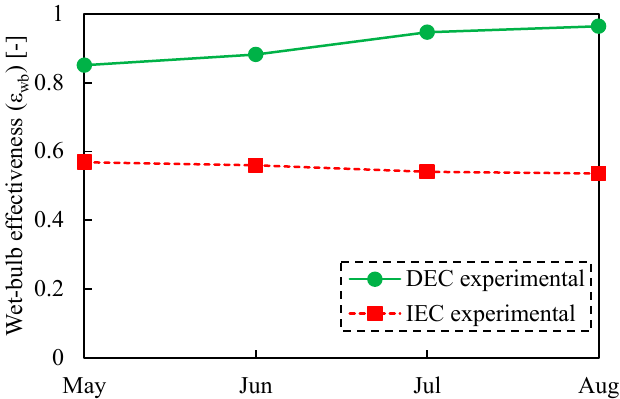
Figure 4. Wet-bulb effectiveness determined from lab-scale DEC and IEC experimental apparatus for summer climatic conditions of Multan [83]. Energies 2020 , 13 , x FOR PEER REVIEW